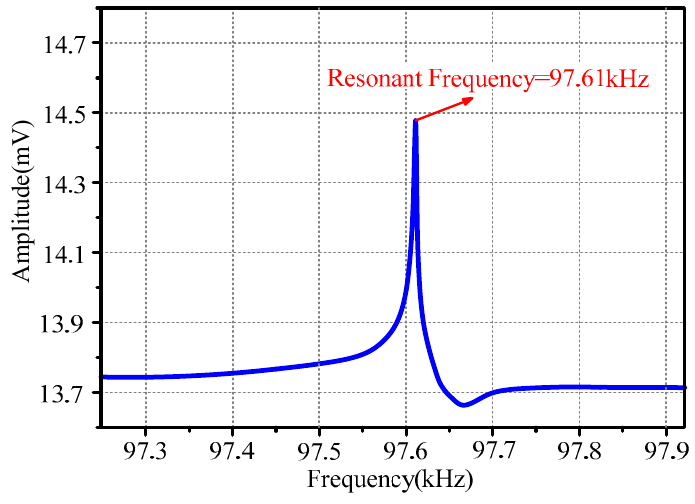
Figure 5. Actual resonant frequency of the HSMS.